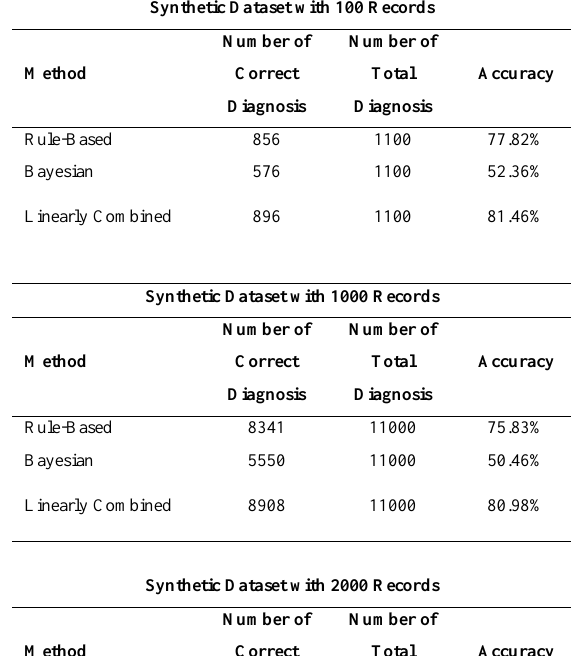
Table 2.The results for the DRCAD inference methods Synthetic Dataset with 100